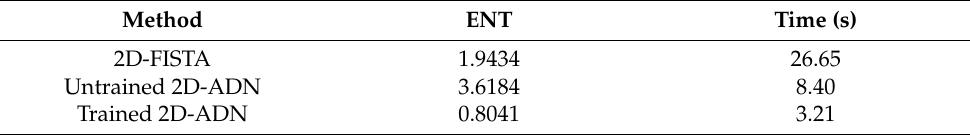
Table 7. Quantitative performance evaluation for the incomplete azimuth measured data. Table 6. Quantitative performance evaluation for the incomplete azimuth measured data.